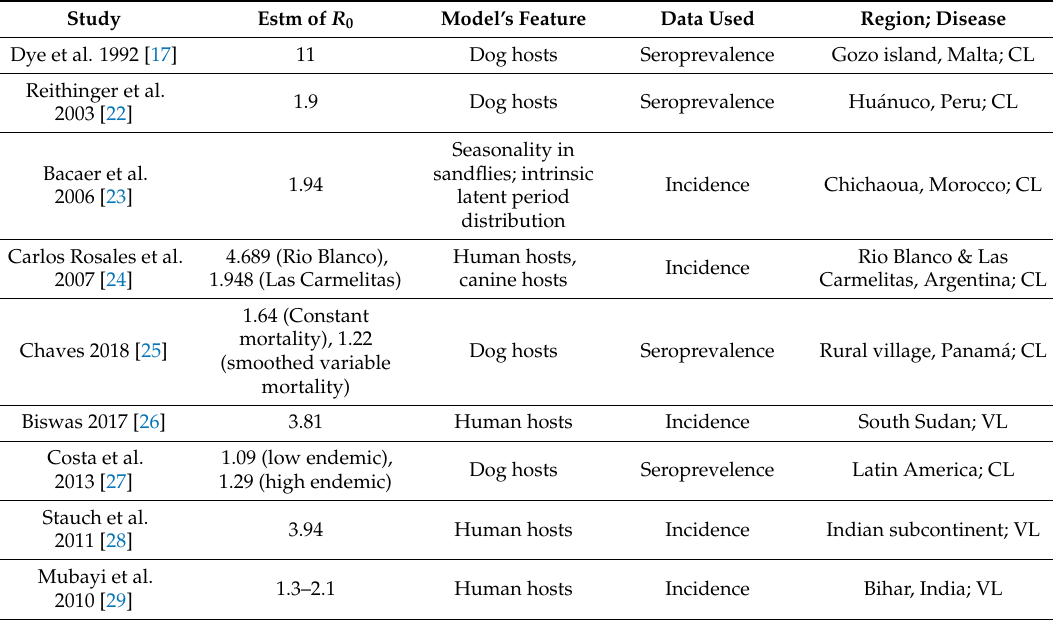
Table 1. Estimates of reproduction number ( R 0 ) from studies in the